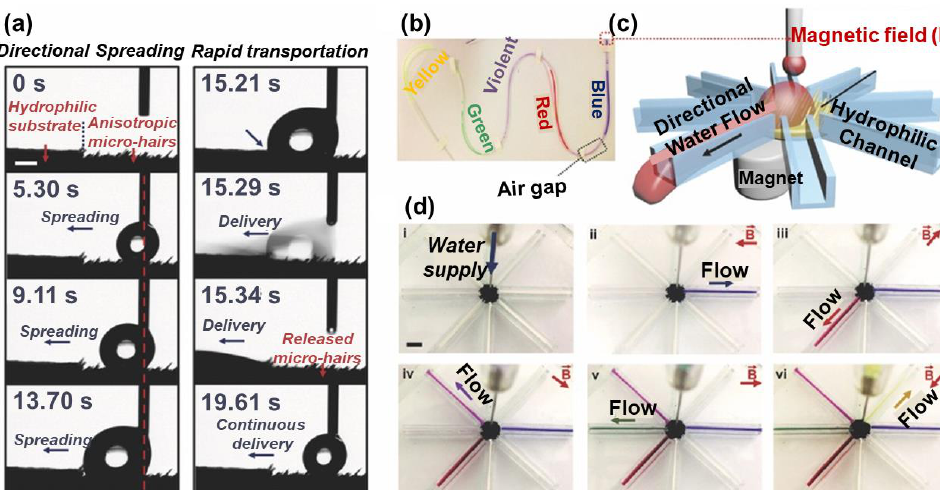
Figure 13. ( a ) Images of droplets moving towards a hydrophilic filter, away from the tilted micro- cilia. ( b ) Scheme of a water flow distributor, consisting of an inspirator underlying the LIS and 8 hydrophilic channels. ( c ) Illustration of controlling droplet sliding direction Water dyed with dif- ferent colors was delivered through a plastic pipe and contacted the surface’s ferromagnetic mi- crocilia surface. By varying the direction of the magnetic field, the tilting direction of the microcilia is changed, which switches the water flow in a defined direction. Reproduced with permission [68]. Copyright 2017, Wiley-VCH.